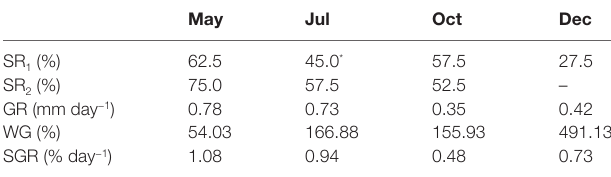
TABLE 1 | Survival rate and growth performance of sea ranched Stichopus monotuberculatus in 2019 (n = 4–6 for GR, WG, and